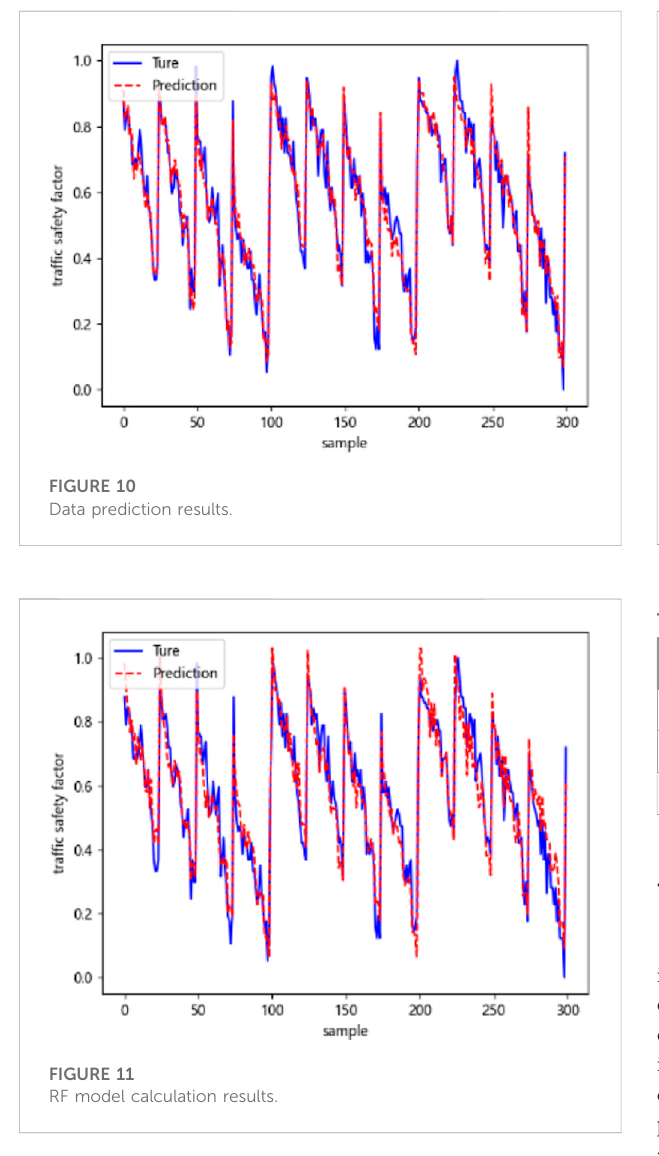
Figure 10, the true value and predicted value in the training fi tting results show a consistent trend of variations, with a relatively small error value, indicating that the model prediction results are better.